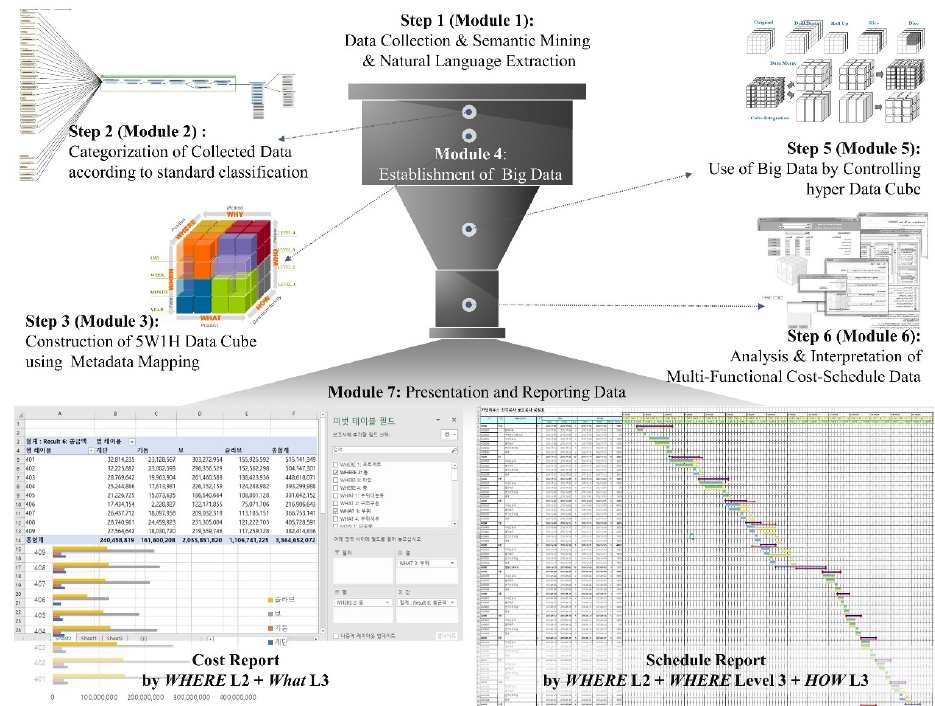
Figure 4. Conceptual Workflow of the Proposed Algorithm for Cost-Schedule Integration.